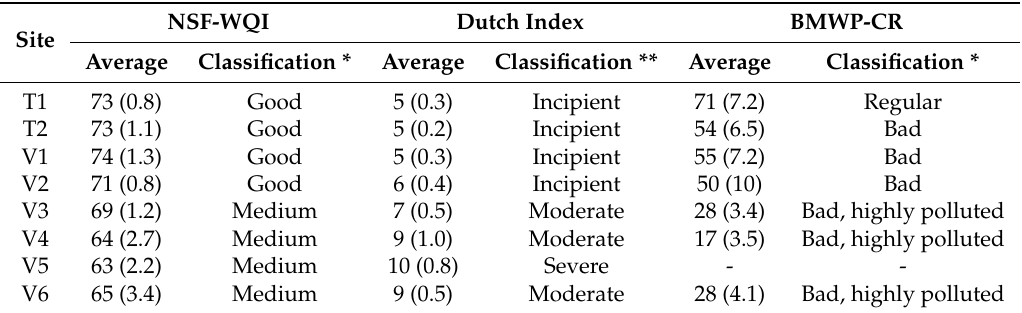
Table 3. Average of water quality indexes per sample site in the Virilla river (standard error in parenthesis). NSF-WQI Dutch Index BMWP-CR Site Average Classification * Average Classification